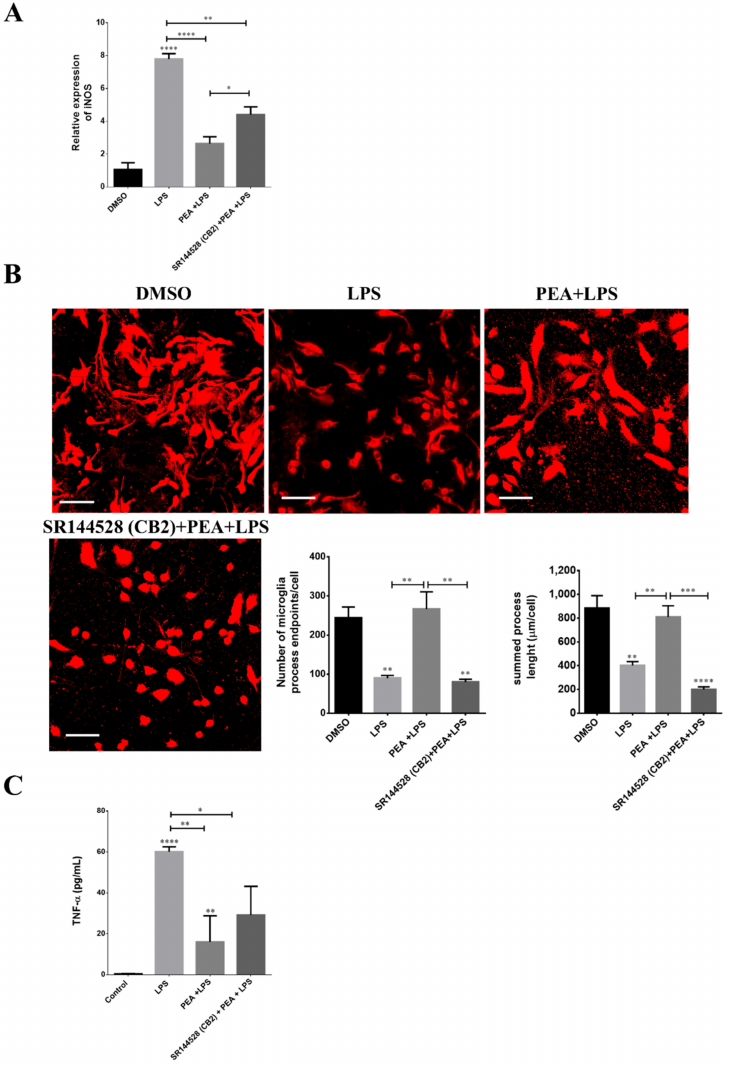
Figure 12. Involvement of cannabinoid type 2 receptor (CB2R) in PEA-neuroprotective effects. N9 cells and mouse primary cortical cultures were incubated with 100 nM SR144528 at 1 h before 100 µ M PEA pre-treatment. After 1 h, they were then exposed to 3 µ g/mL LPS. ( A ) Histograms relative to the quantification of Western blot bands of iNOS in N9 cells, after DMSO, LPS, PEA + LPS and SR144328 + PEA + LPS treatments. Data are shown as the mean ± S.E.M. ( n = 3 independent experiments) ( B ) N9 cells were seeded on porcine gelatin pre-treated coverslips and treated as described above. Cells were stained with the membrane dye DiI and fixed. On the left, fluorescence images acquired by a 63 × magnification on Leica TCSSP2 laser scanning confocal microscope. Scale bar: 50 µ m. On the right, histograms relative to the quantification of process endpoints/cells and process length/cells. Data are shown as the mean ± S.E.M. of different images analyzed ( n = 5, total number of cells present in each image n = 30, total number of cells analyzed for each group n = 150). ( C ) The amount of TNF- α released into the culture medium in mouse primary cortical cultures. Cells were treated as described above, and the amount of this cytokine was quantified at 6 h from LPS application. Data are shown as the mean ± S.E.M. of measurements obtained in three independent experiments ( n = 3). Differences between groups were tested for significance by applying the ANOVA test and Tukey post hoc test. * p < 0.05, ** p < 0.01, *** p < 0.001, **** p <